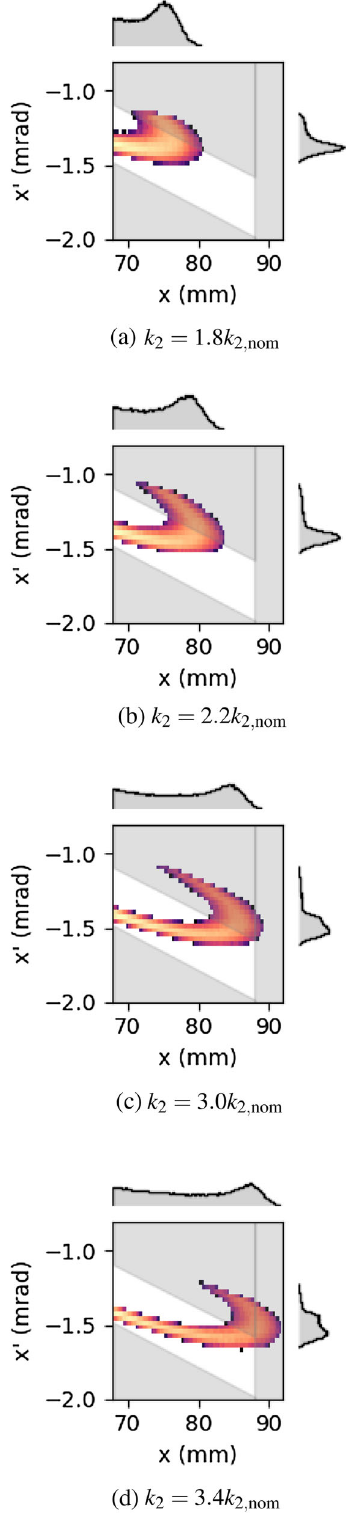
FIG. 10. Extracted beam in phase space on the high-field side upstream of the ZS simulated as a function of sextupole strength , and ; nom with an octupole strength of k 3 L ¼ − 2 . 45 m − 3 and nominal extraction bump